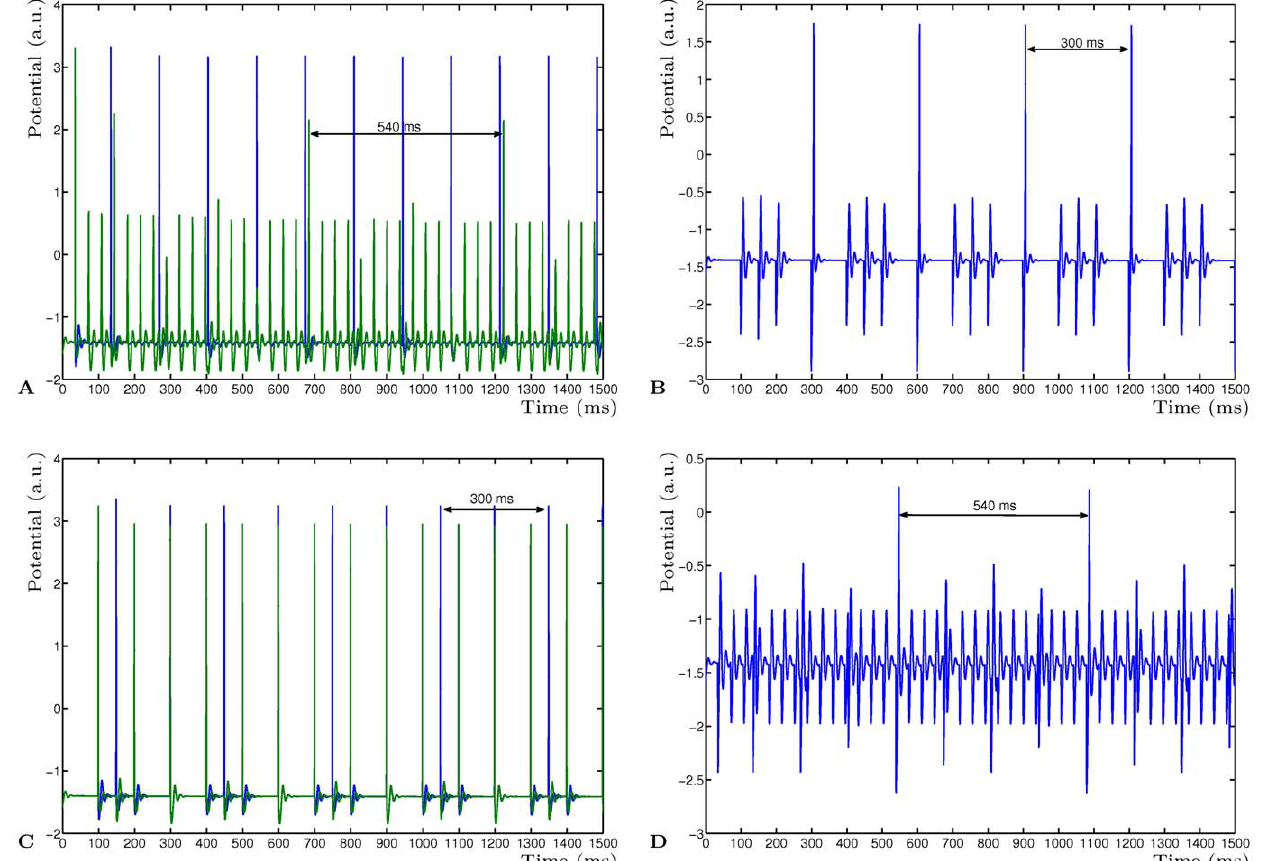
Figure 1. Determining the ghost frequency of two input frequencies. A Activity of neurons X 1 (blue) and X 2 (green) driven by two input frequencies 10 Hz (100 ms) and 6.67 Hz (150 ms). B Activity of the read-out neuron V clearly showing the emerging fundamental frequency of 3.33 Hz (300 ms). C Neurons X 1 (blue) and X 2 (green) driven by two different input frequencies of 27.78 Hz (36 ms) and 7.4 Hz (135 ms). D Activity of neuron V showing the emergent fundamental frequency of 1.85 Hz (540